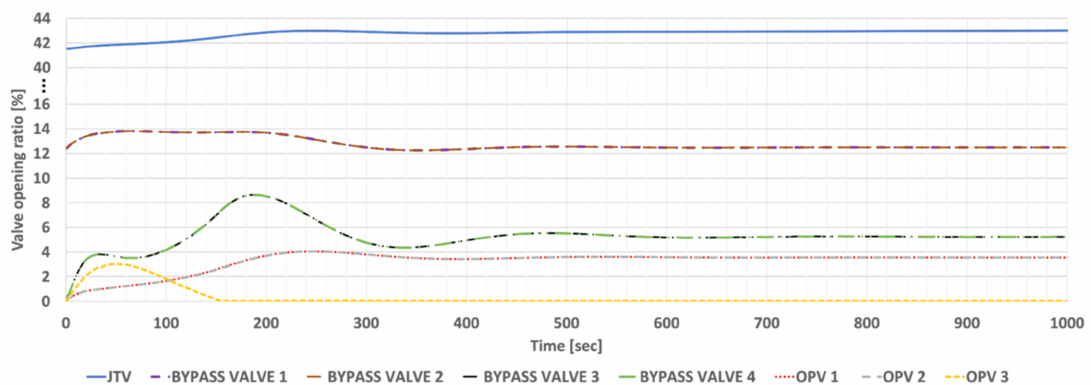
Figure 16. Valve opening ratio when two engines are